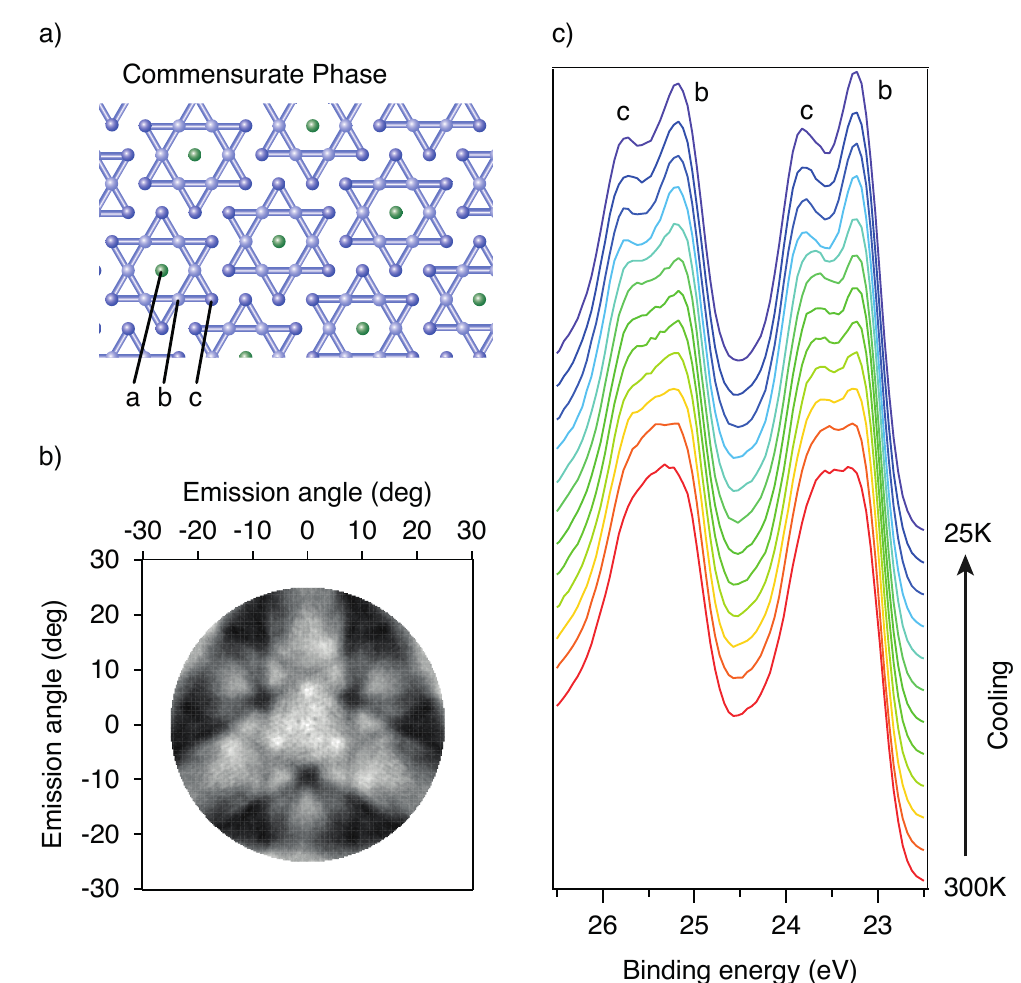
Figure 3. X-ray photoelectron spectroscopy and diffraction at 1T- TaS 2 . Panel ( a ) shows the Star- of-David arrangement of the Ta atoms in the CCDW phase with the central atom ( a ), the nearest neighbour atoms ( b ) and the next-nearest neighbour atoms ( c ). Panel ( c ) shows, as a function of temperature, that 1T- TaS 2 undergoes a phase transition (NCCDW → CCDW) to a charge-separated star of David reconstruction at low temperature panel ( a ), associated with chemically shifted Ta 4f states. Panel ( b ) shows that the wide angle lens ArTOF of the SurfaceDynamics endstation is able to detect next to the X-ray photoelectron spectra a full set of X-ray diffraction pattern with a collection angle of 56 ◦ at an energy window of